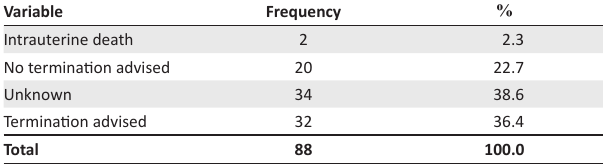
TABLE 4: Frequency and percentage of termination of